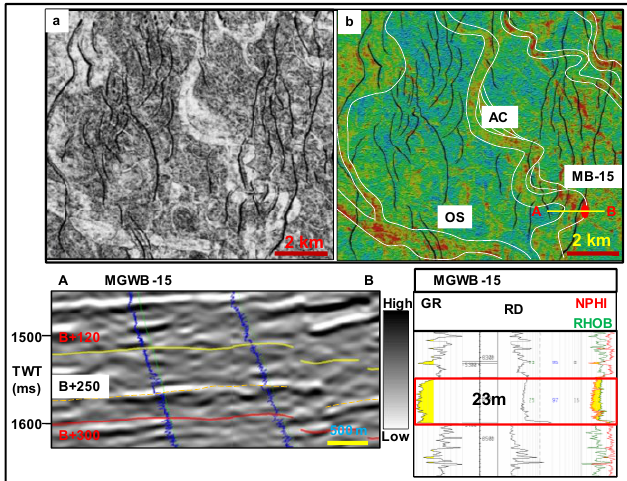
Figure 5: Dip steered similarity (a) and RMS amplitude (b) in Horizon slice B+250. The seismic section along A-B shows strong amplitude at the sand position confirmed by log data. Red ellipse indicates well location.